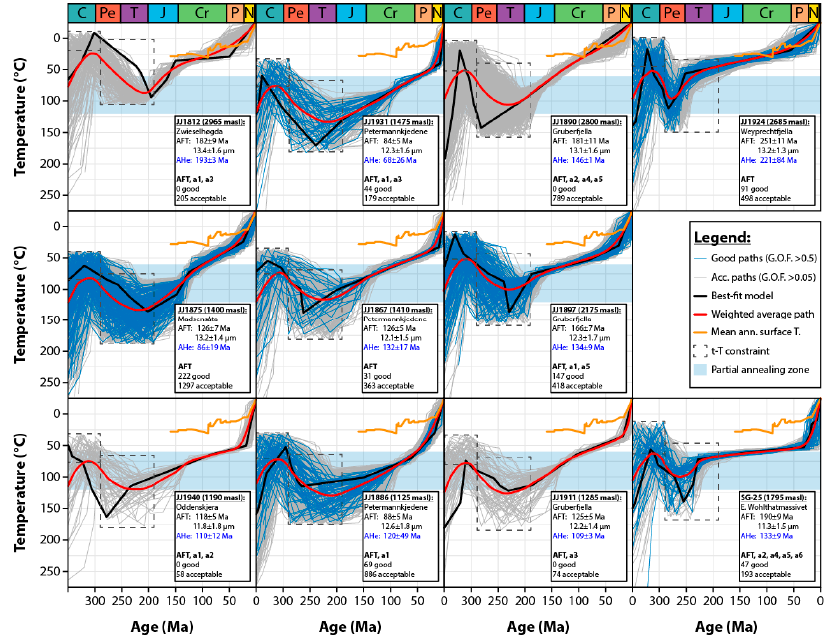
Figure 7. Modelled thermal histories of samples from Wohlthatmassivet. For explanations, see Figure 6.